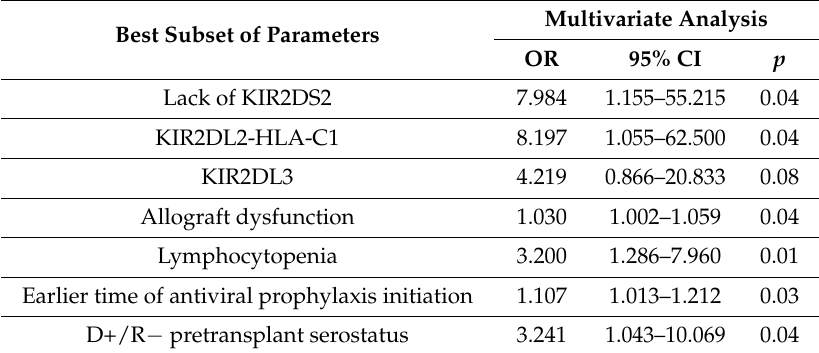
Table 5. Best subset of variables with the strongest predictive value for the incidence of posttransplant CMV infection according to the multivariate